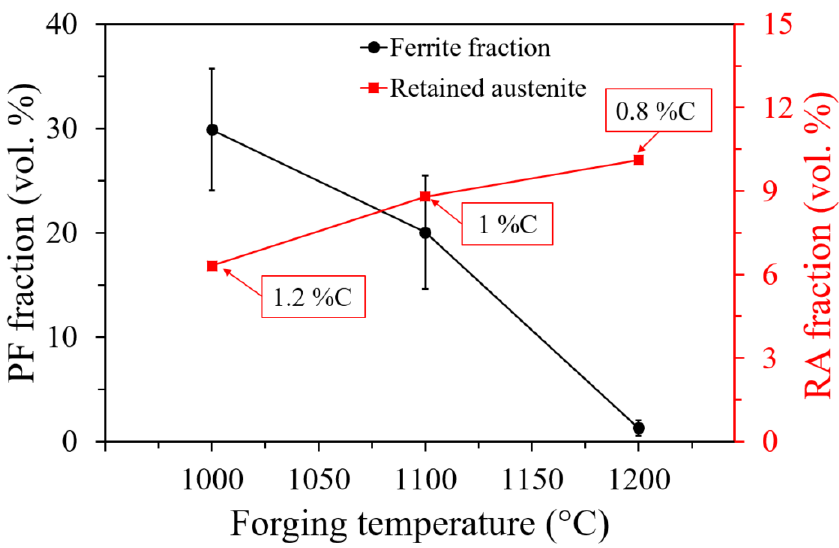
Figure 7. The effect of the forging temperature on the PF and RA fractions and carbon content of the austenite.